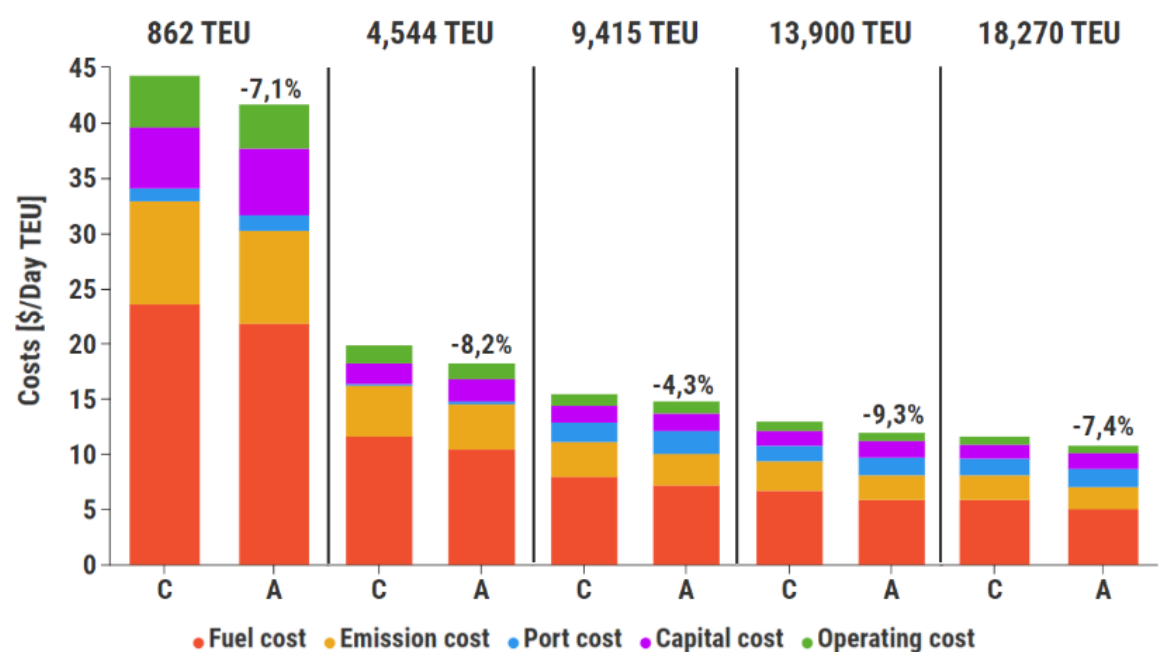
Figure 10. Daily costs of conventional and autonomous vessels per container.